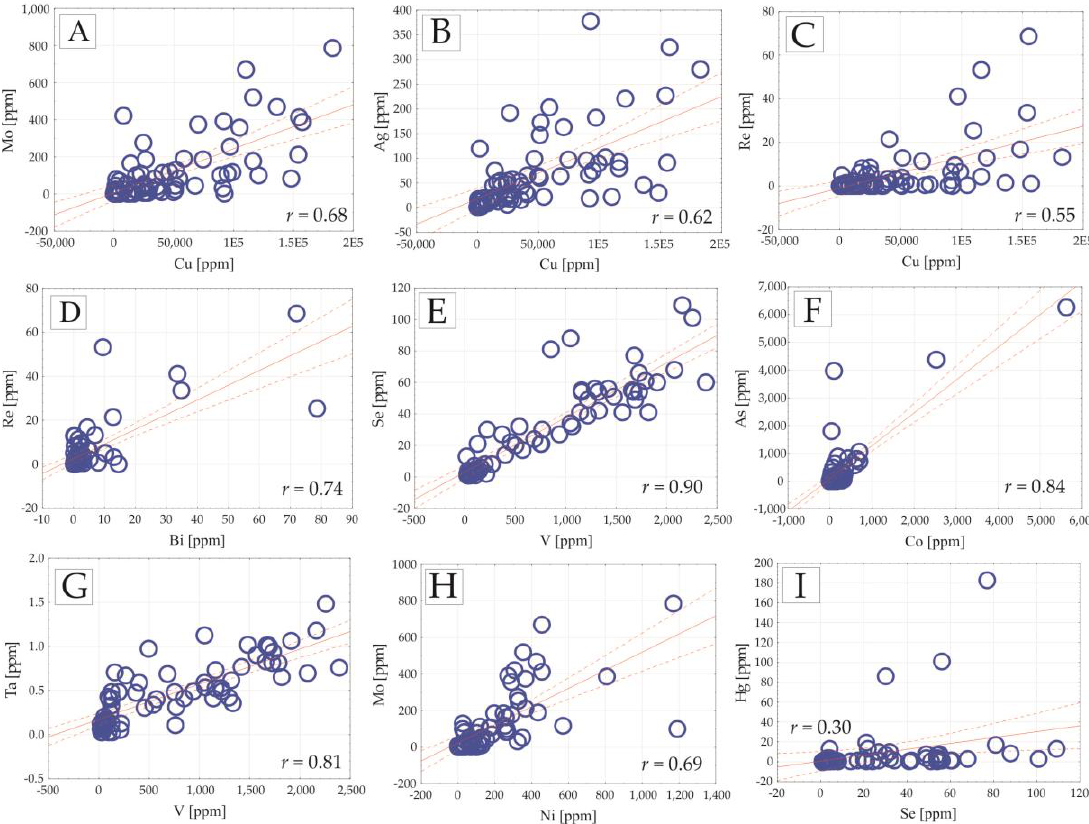
Figure 16. Scatter plots with marked trend line of bulk-rock analyses of Cu-Ag sulfide ores from the Kupferschiefer deposits on the Fore-Sudetic Monocline in Poland: ( A ) Cu vs. Mo, ( B ) Cu vs. Ag, ( C ) Cu vs. Re, ( D ) Bi vs. Re, ( E ) V vs. Se, ( F ) Co vs. As, ( G ) V vs. Ta, ( H ) Ni vs. Mo, and ( I ) Se vs. Hg. Note: 95% confidence intervals are shown as the red dotted lines, while the line of best fit is shown as the red line.